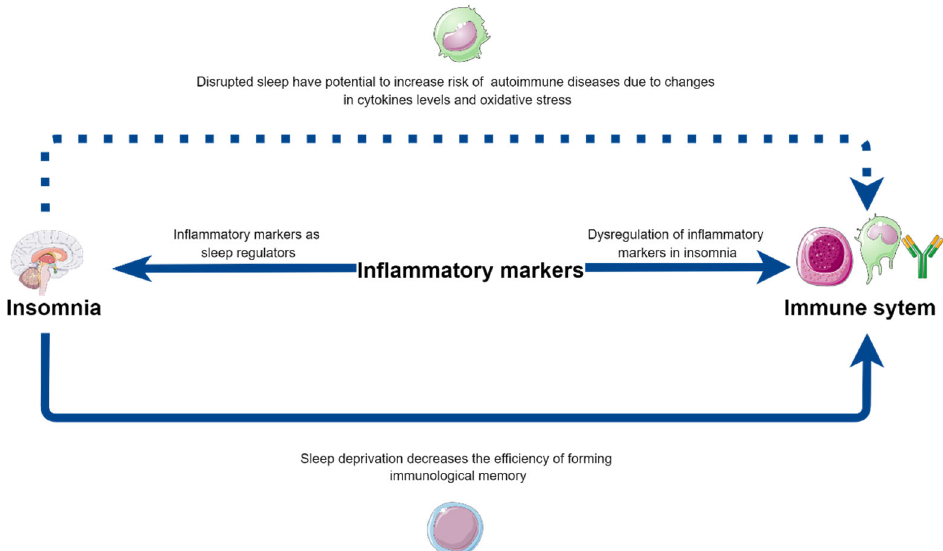
Figure 2. The potential bilateral influence of insomnia on immune system functioning—directly and via inflammatory markers, as well as their contribution to the increased risk of autoimmune diseases in insomniacs. Parts of the figure were drawn by using pictures from Servier Medical Art (http://smart.servier.com/, accessed on 18 June 2022), free and opened software, which is licensed